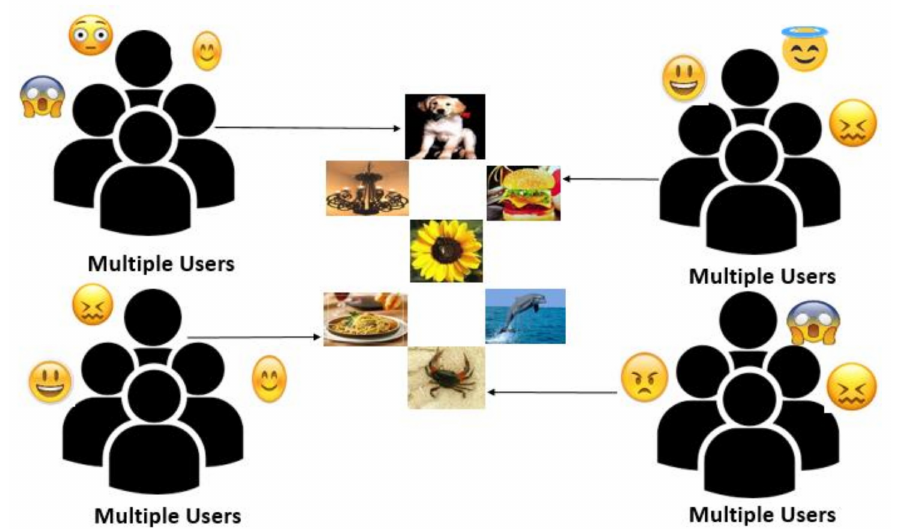
Figure 1. A visual representation of emotion perception idea based on human-object interaction, where multiple sample users are interacting with real-life object images and perceiving diverse kind of